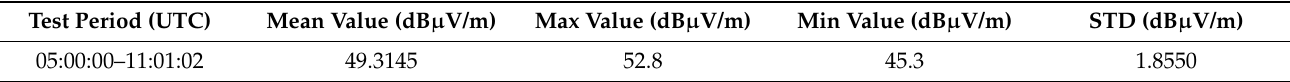
Table 4. Statistics of the low-frequency time-code signal on 22 June 2020.